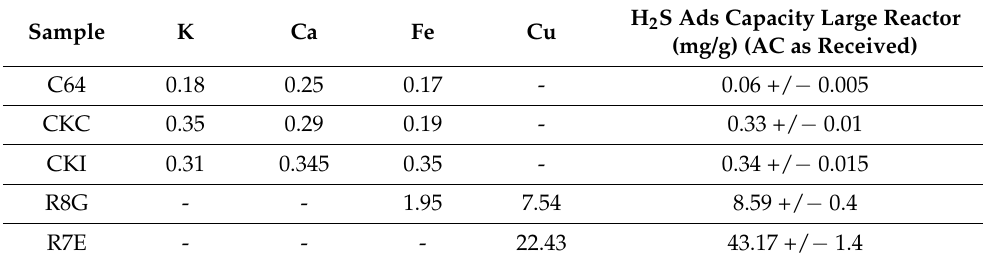
Table 5. Atomic concentration percentages and large reactor